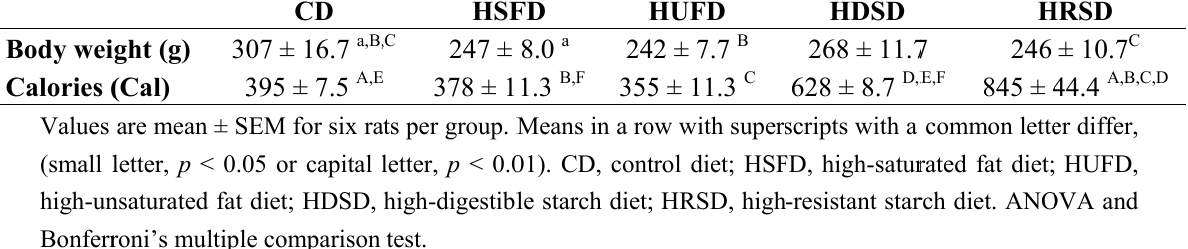
V Variable Gluco ose (mg/dL) Insuli in (ng/mL) HOM MA Index Values are mean ± S p < 0.0 5 5 or capital le fat diet t; HDSD, hig multiple e